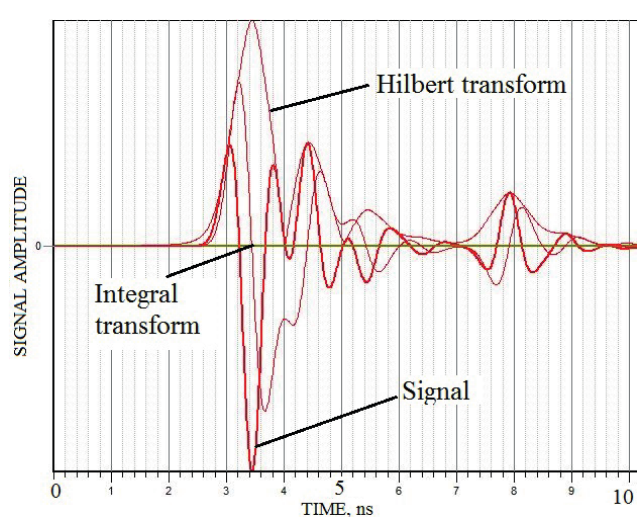
Fig. 3. Signal diagrams in a model experiment (synthesized data).